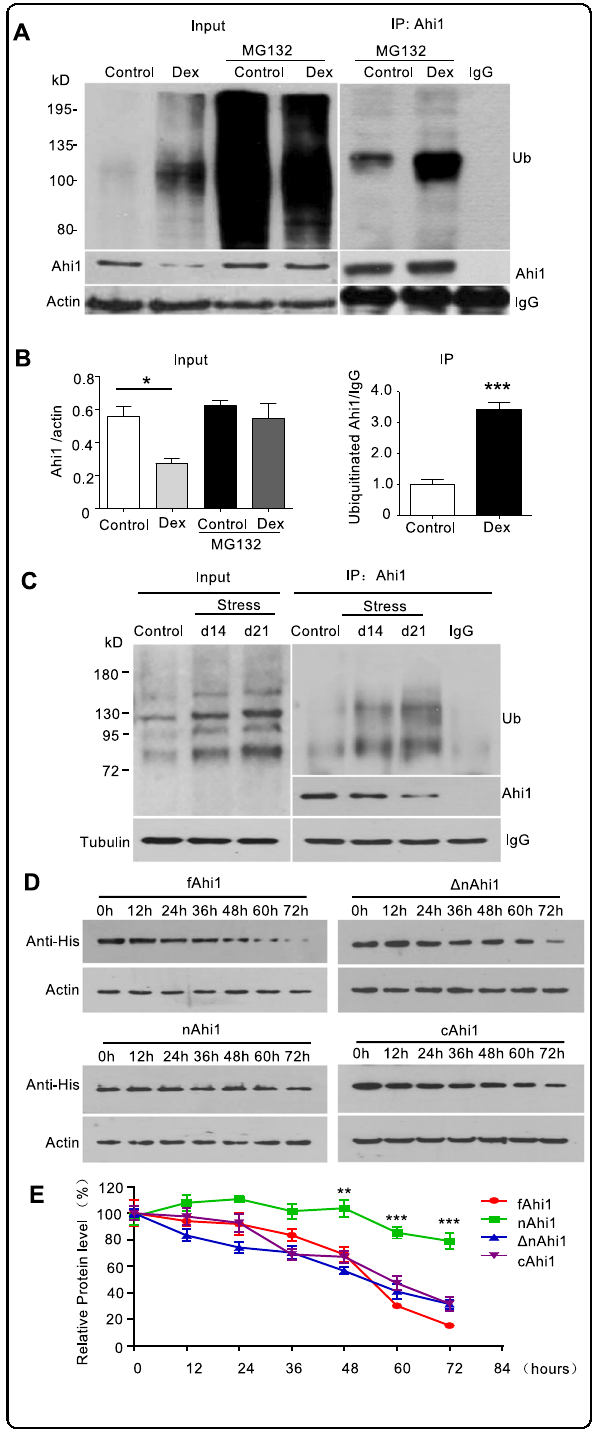
Fig. 3 Glucocorticoid treatment and stress promoted Ahi1 protein degradation through ubiquitination. A PC12 cells were treated with or without Dex (20 μ M) for 72 h, and then treated with or without MG132 (5 μ M) for 10 h. Cell lysates were collected for the immunoprecipitation with Ahi1 antibody. Ahi1 and ubiquitinated proteins were detected with anti-Ahi1 and anti-ubiquitin antibodies. B The relative levels of Ahi1 (Ahi1/ β -actin) ( F (1,8) = 3.341, * P = 0.0175) and ubiquitinated Ahi1 (Ub/IgG) ( t (4) = 8.521, *** P = 0.001) were obtained from three independent experiments. C After spatial restraint stress for 14 days or 21 days, mouse hypothalamic tissues were collected for the immunoprecipitation with Ahi1 antibody. Ahi1 and ubiquitinated Ahi1 protein were examined by western blotting. D Different Ahi1-His fusion proteins expressing full length (fAhi1, aa 1 – 1047), N-terminal (nAhi1, aa 1 – 284), Ahi1 without N-terminal region ( Δ nAhi1, aa 285 – 1047), and C-terminal (cAhi1, aa 651 – 1047) were transfected into PC12 cells. The co-transfected cells were treated with Dex (20 μ M) for different times (0 – 72 h). Ahi1-His levels were determined by Western blotting with His antibody. E The degradation of different Ahi1-His fusion proteins ( F (3,84) = 55.50, *** P < 0.0001 versus control fAhi1, n = 4 cell